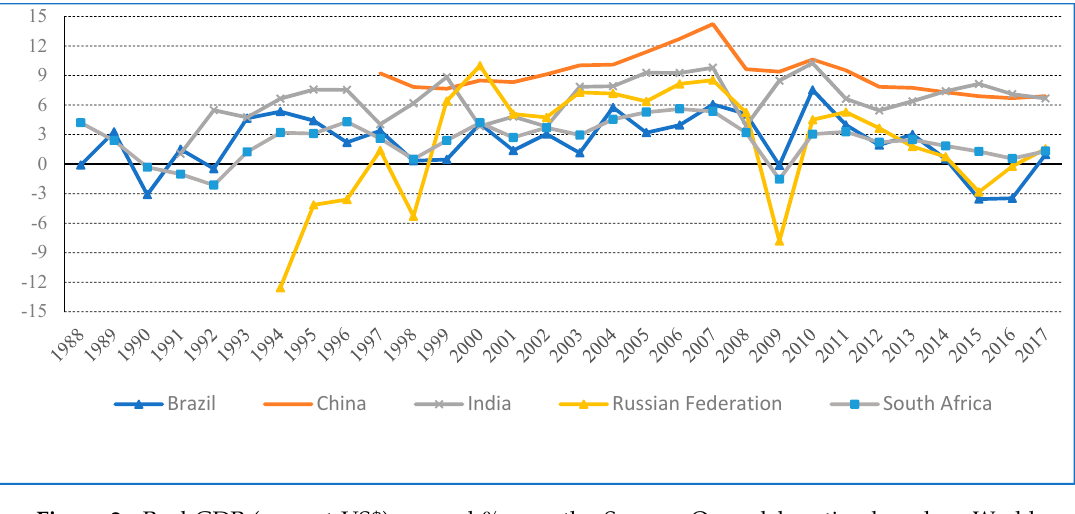
Figure 2. Real GDP (current US$), annual % growth. Source: Own elaboration based on World Development Indicators (World Bank).